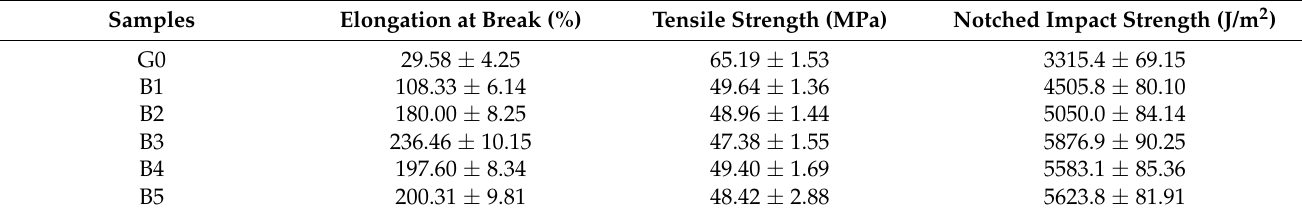
Table 5. Effect of PLA-g-GMA content on mechanical properties of PLA/PPC/PLA-g-GMA